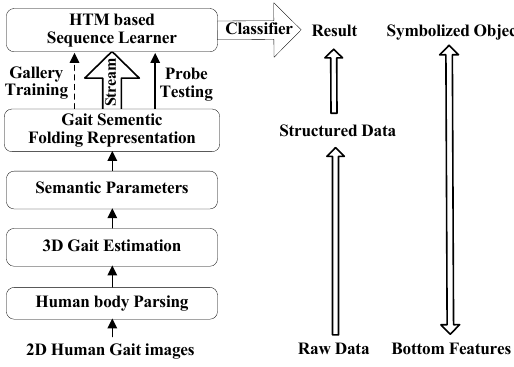
Figure 1. Overview of the GRU-GSFSL